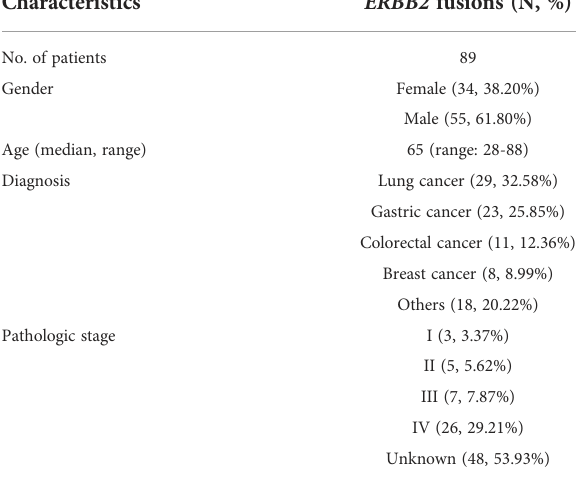
TABLE 1 A summary of ERBB2 fusion tumor patients ’ demographic and clinical characteristics in Chinese cohort. Characteristics